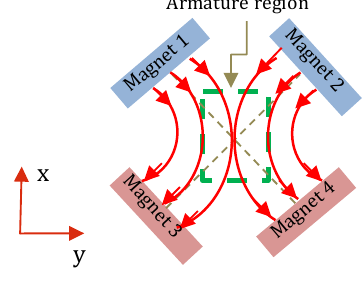
Figure 3: Side view of magnetic field distributions for stucture of Figure 1(b)